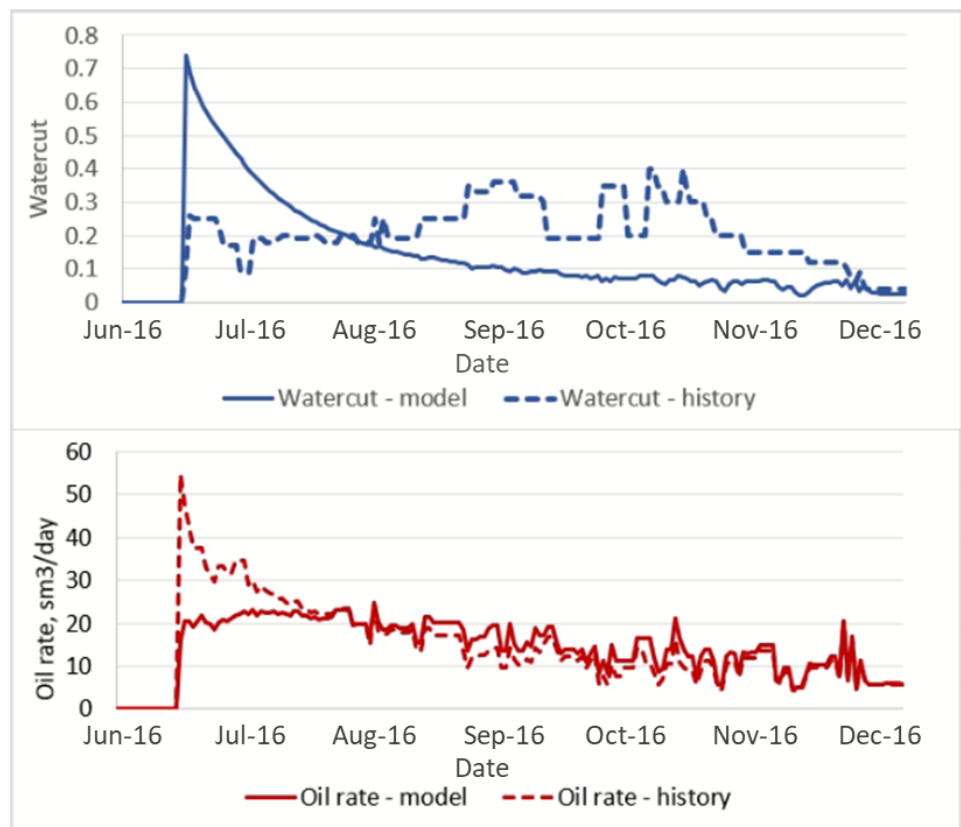
Figure 2. Results of history matching.